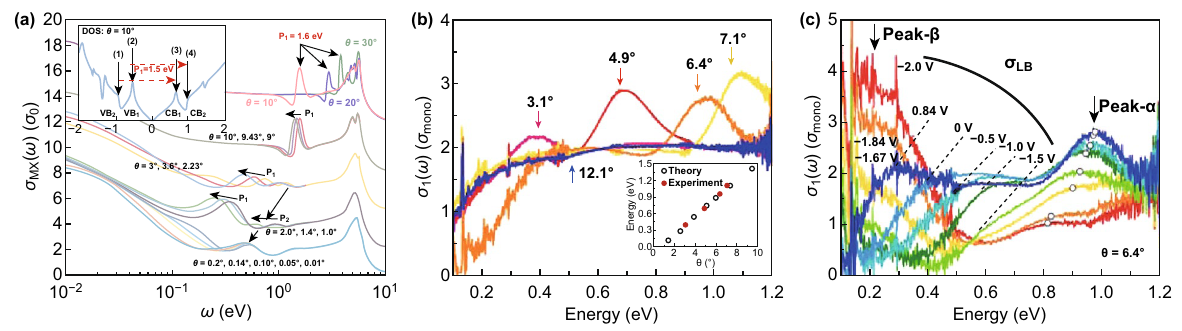
Fig. 5 a Optical conductivity of some commensurate and incommensurate tBLG structures, and inset shows the leading transition procedures contributing to the formation of the optical conductivity peaks [126]. b Optical conductivity σ 1 ( ω ) of the different twisting angle tBLG samples, and inset shows comparison of the observed peak position and theoretical prediction. c Optical conductivity of gated tBLG ( θ = 6.4°) for differ- ent gate voltages V G [127]. Adapted with permission from Refs. [126,